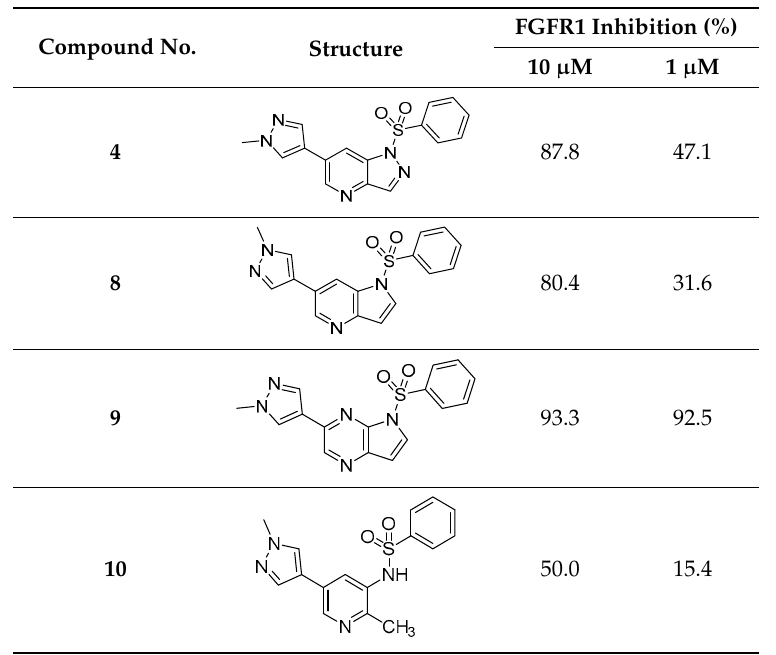
Table 3. Structures and FGFR1 enzymatic activities of compounds 11 – 22 .